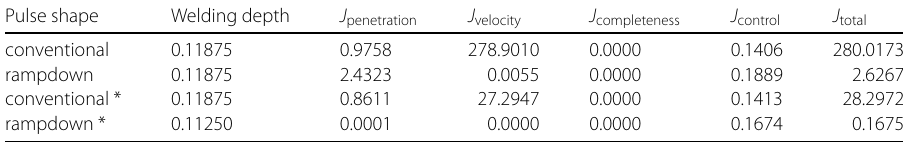
Table 2 Numerical report on simulations with the conventional and the linear rampdown pulse shapes, and locally optimal pulse shapes * starting from corresponding initial guesses Pulse shape Welding depth J penetration J velocity J completeness J control J total conventional 0.11875 0.9758 278.9010 0.0000 0.1406 280.0173 rampdown 0.11875 2.4323 0.0055 0.0000 0.1889 2.6267 conventional * 0.11875 0.8611